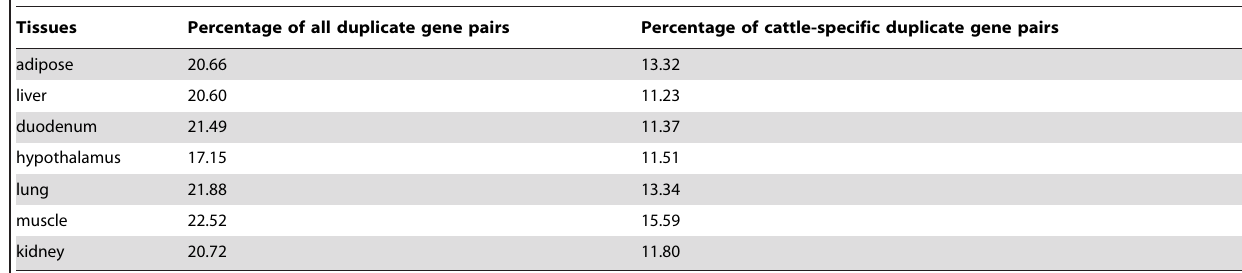
Tissues Percentage of all duplicate gene